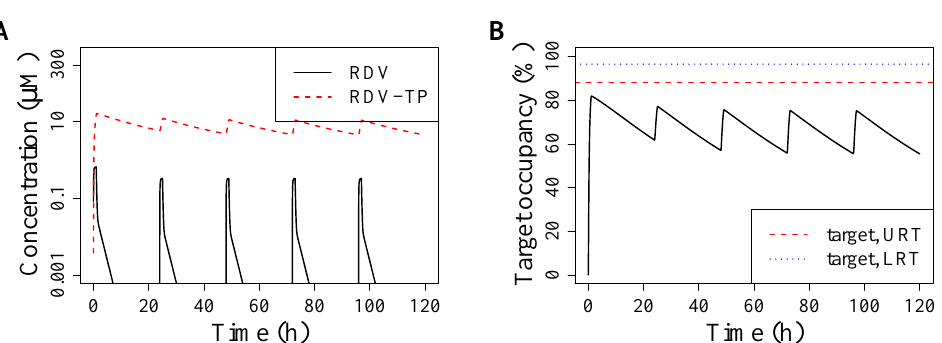
Figure 3. Pharmacokinetics and target occupancy with standard RDV dosing. ( A ) Shows the simulated pharmacokinetics for standard dosing of RDV, i.e., once daily 200 mg loading dose, 100 mg thereafter, infused over 1 h (recommended range 30 min to 2 h). We simulate five days of treatment (time given in hours). The concentration of RDV in plasma (black line) and RDV-TP in blood cells (PBMCs, red line), is given in µ M. ( B ) Shows the resulting target occupancy as obtained from the intracellular RDV-TP concentration in ( A ) and Equation (2). The red dotted line indicates the minimal effective target occupancy for the LRT, and the green dotted line the same for the URT. Both were calculated with Equation